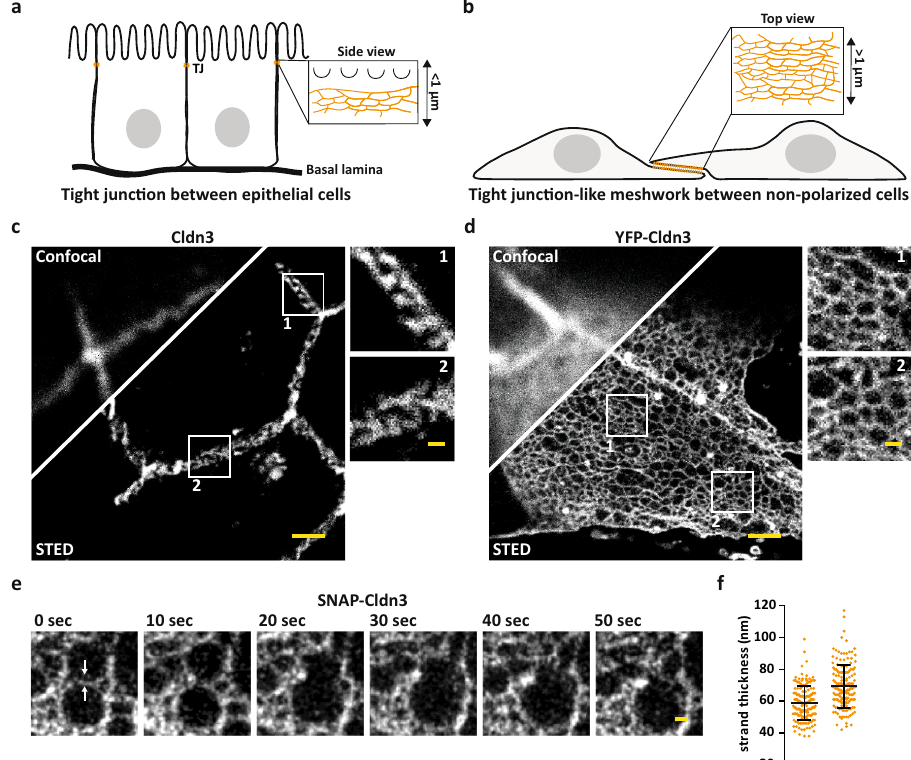
Fig. 1 | STED microscopy reveals the nanoscale organization of TJ meshworks. a Scheme illustrating the endogenous TJ at the most apical cell-to-cell contact in epithelial cells. b Scheme illustrating TJ-like meshwork formed in fl at overlapping areas of claudin transfected non-polarized cells. c , d Representative confocal and STEDimageofanendogenousformedTJlabeledforCldn3(2 nd -Atto647N)between epithelialcellsfromtissueofmouseduodenum( c )andTJ-likemeshworkformedby overexpressed YFP-Cldn3 ( α -GFP-NB-Atto647N) between two COS-7 cells ( d ). e Representative single-color STED time series (1frame/10s) ofa TJ-like meshwork in an overlapping region of living COS-7 cells expressing SNAP-Cldn3 (BG-JF646).